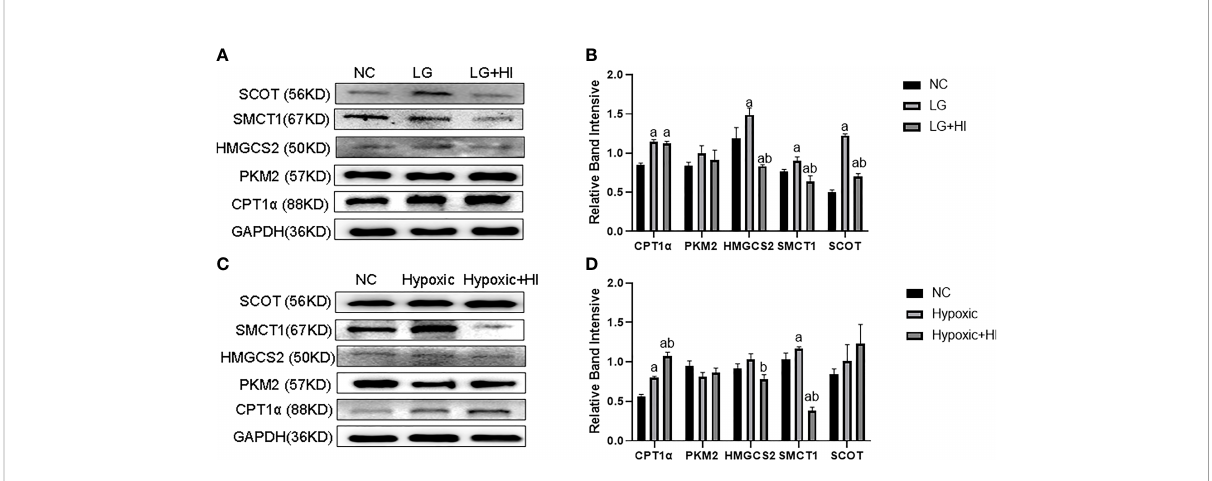
FIGURE 7 Effect of high insulin level on metabolic switch to BHB in HK2 cells under hypoglycemic and hypoxic conditions. (A) Expression of CPT1 a , PKM2, HMGCS2, SMCT1, and SCOT in HK2 cells under high insulin and low glucose conditions; (B) Quantitative results of corresponding proteins expression in panels (A) ; (C) Expression of CPT1 a , PKM2, HMGCS2, SMCT1, and SCOT in HK2 cells under high insulin and low oxygen conditions; (D) Quantitative results of the corresponding proteins expression in panel (C) . a p < 0.05, compared with the NC group; b p < 0.05, compared with the LG/Hypoxic